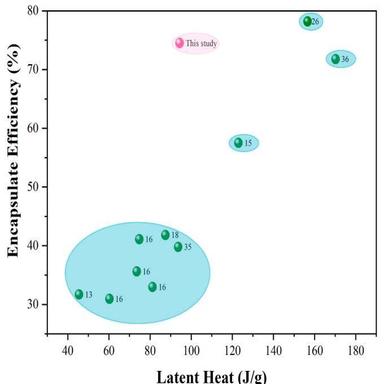
Compared with latent heat and encapsulate ratio (Er) between this work (PS-5) and the reported EPCMs.